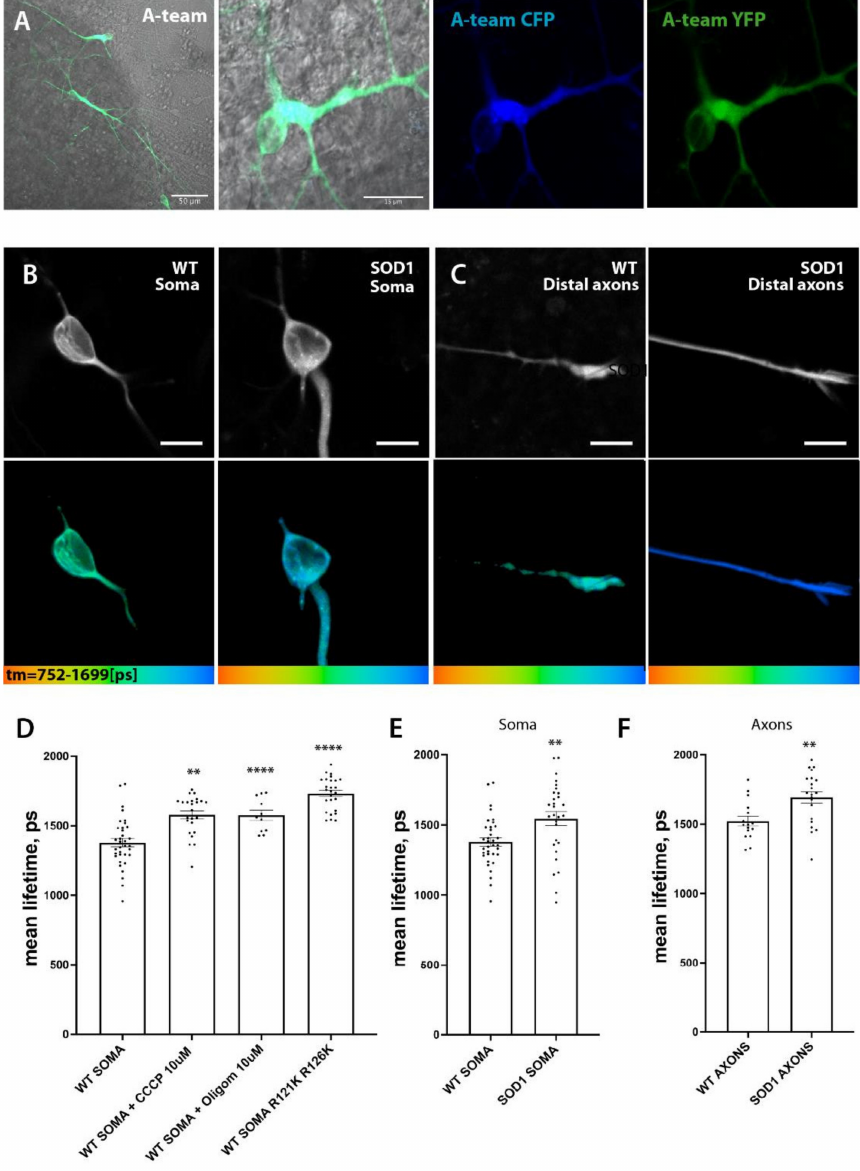
Figure 8. A-team FLIM reveals lower levels of ATP in SOD1 mutant soma and distant axons. ( A ) Low and higher magnification of the microfluidic chamber illustrating motoneurons lentivirally transfected with A-team FRET sensor. Individual subunits of the sensor could be visualized via their fluorescence in CFP and YFP channels. Low to moderate transfection efficiency allowed identifying single cells and thereby measurements of individual soma, proximal and also distal axonal (i.e., growth cones) compartments within each chamber. ( B , C ) Representative single images showing donor fluorescent intensity of ATP FRET sensor A-team and its corresponding color-coded range of mean-lifetime FLIM measurements within each cell. Images show different cell compartments, somata ( B ) and axons ( C ) in WT and SOD1 mutant MN cells. Color-coded scales of mean-lifetime values are shown at the bottom of the gallery. Scale bar is 10 µ m. ( D ). Bar graphs comparing average mean lifetimes